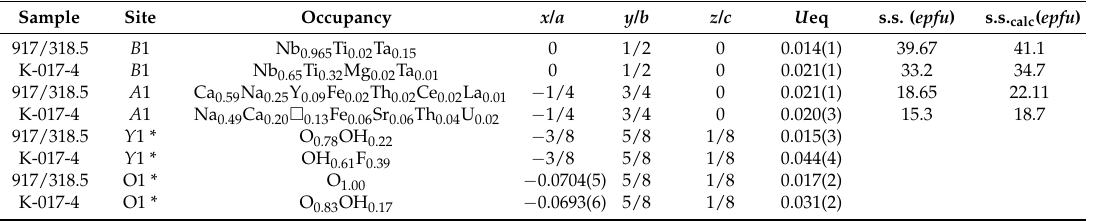
Table 7. Atom coordinates, displacement parameters (Å 2 ) and site occupancies for oxycalciopyrochlore